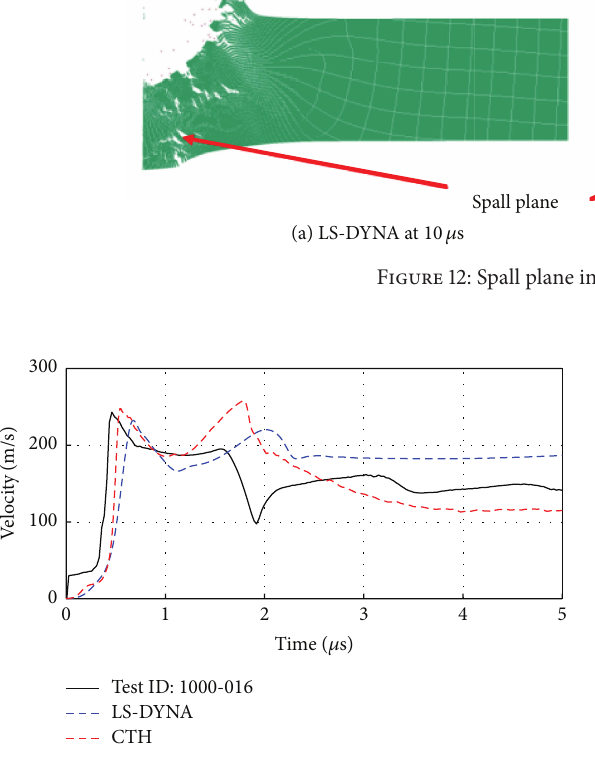
Figure 13: Free surface velocity comparison of Test 1000-016 (impact velocity: 5.338 km/s).